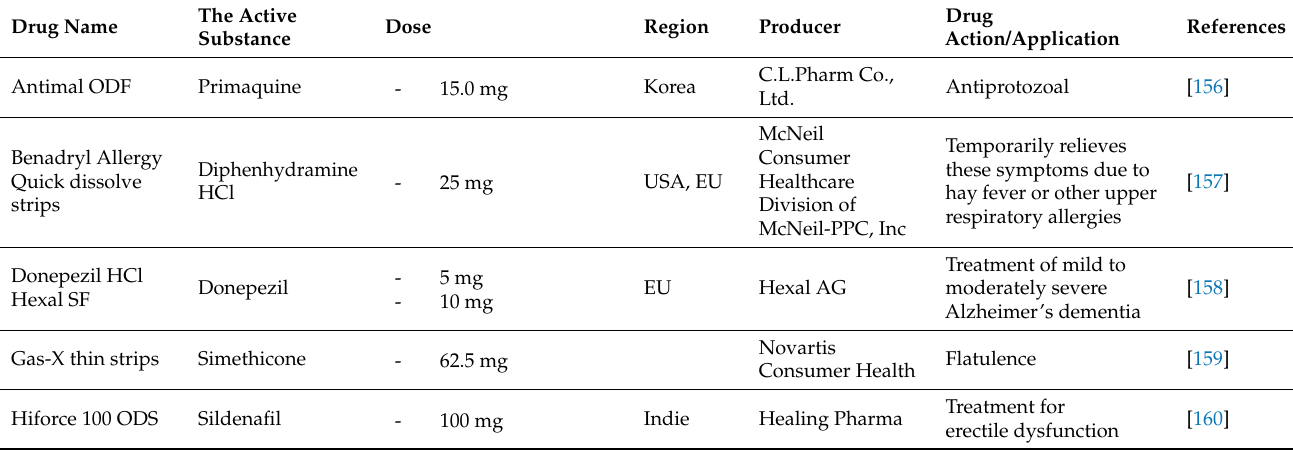
Table 3. Discontinued